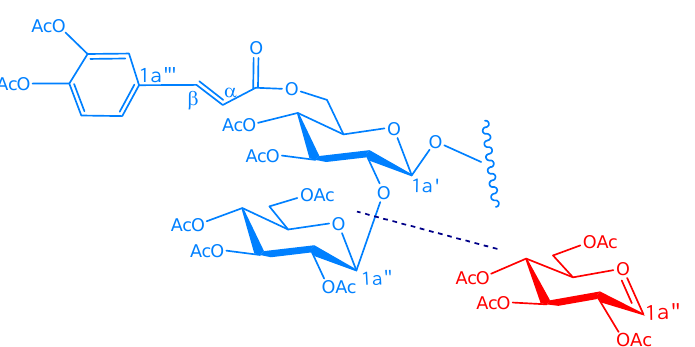
Figure 4 . EI-MS fragmentation of KSR3 .